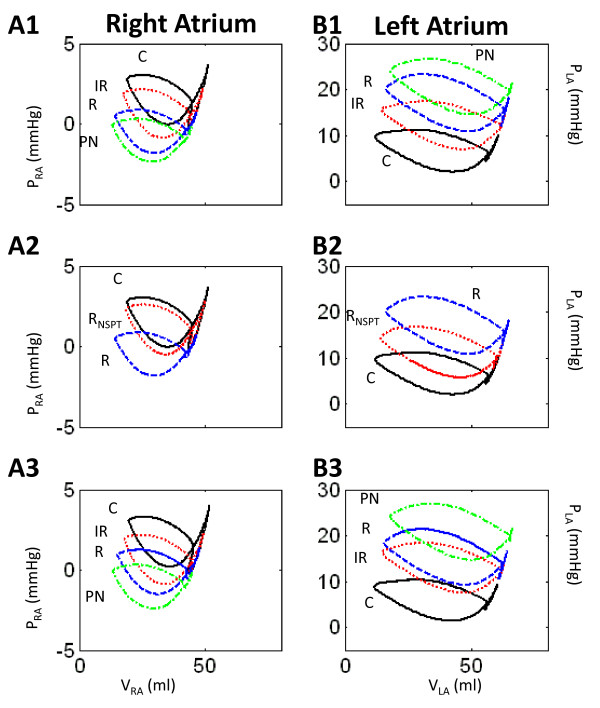
Comparison of Atrial P-V Loops. Comparison of normal atrial P-V loops (C, solid line) with those occurring in various types of LVDD. In Panels 1 and 2, LV systolic contractility is normal, whereas in Panel 3, systolic contractility is increased. Panel 2 compares a normal (RNSPT) with a stiffened (R) septum in R-type LVDD. Other abbreviations are as in Figure 3.